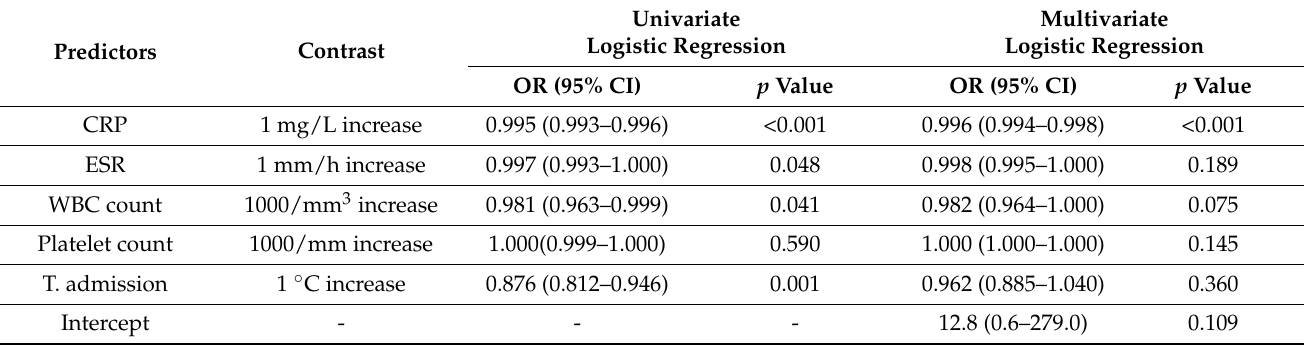
Table 3. Univariate and multivariable logistic regression with the biological and clinical markers in patients aged < 48 months to discriminate S. aureus OAIs (n = 18) from K. kingae OAIs (n =